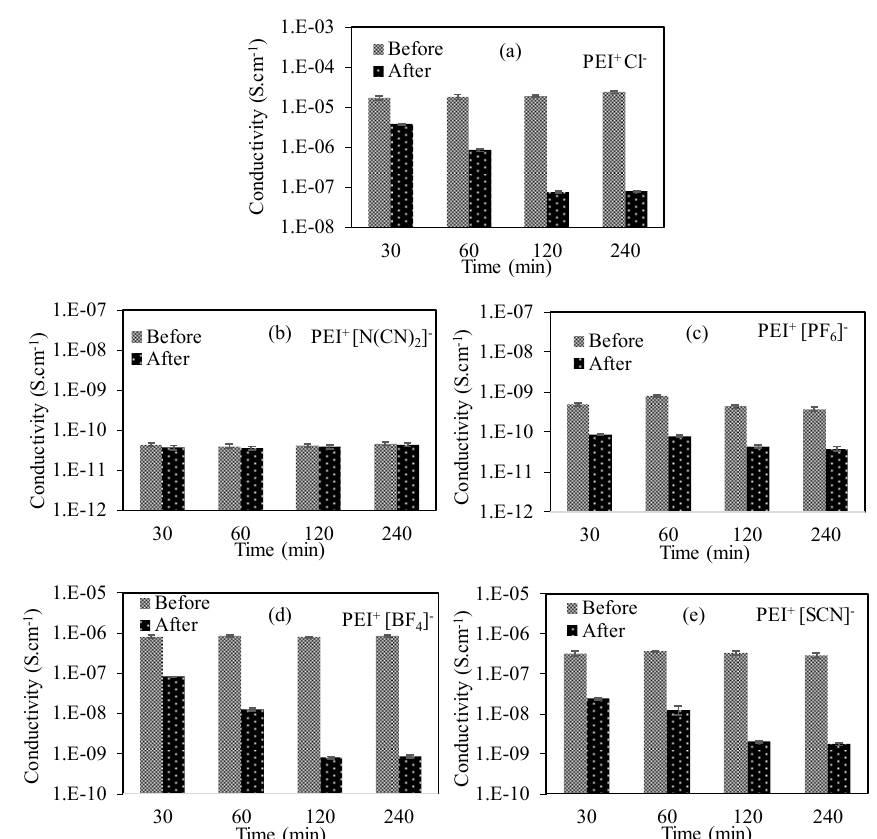
Figure 5. The changing on conductivities of ( a ) PEI + Cl − , ( b ) PEI + [N(CN) 2 ] − ( c ) PEI + [PF 6 ] − , ( d ) PEI + [BF 4 ] − , and ( e ) PEI + [SCN] − PIL cryogels under CO 2 gas exposure. [200 mL / min flow rate].